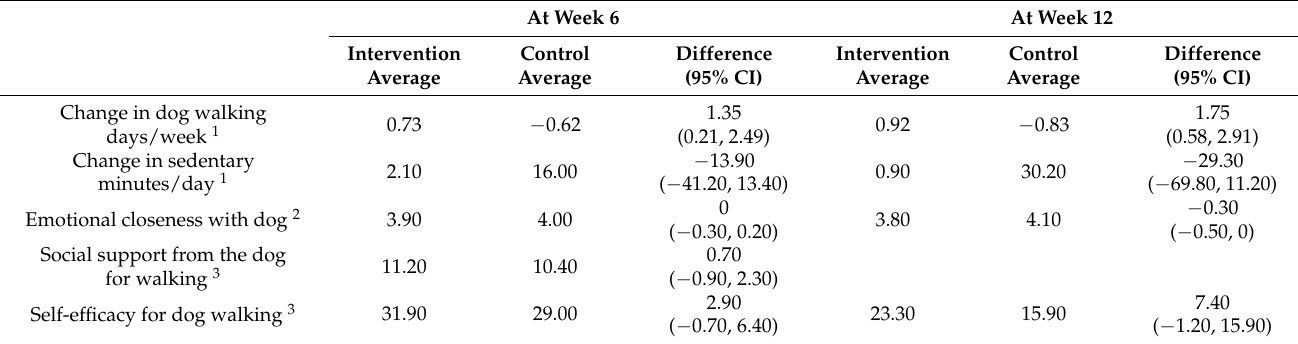
At Week 6 At Week 12 Intervention Control Difference Intervention Control Difference Average Average (95% CI) Average Average (95% CI) 0.73